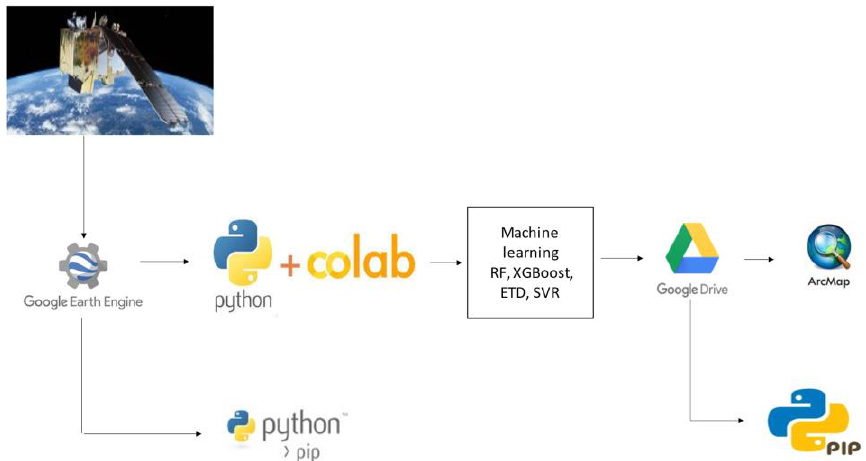
Figure 3. Research process flowchart.